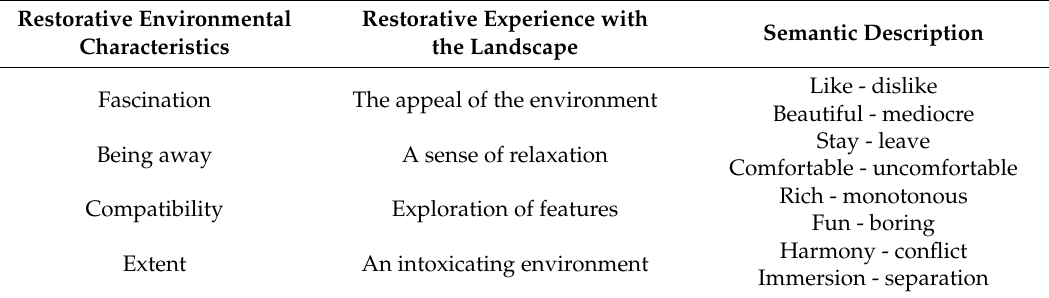
Figure 4. Field experiment process. Table 3. Semantic descriptions of environmental restoration.